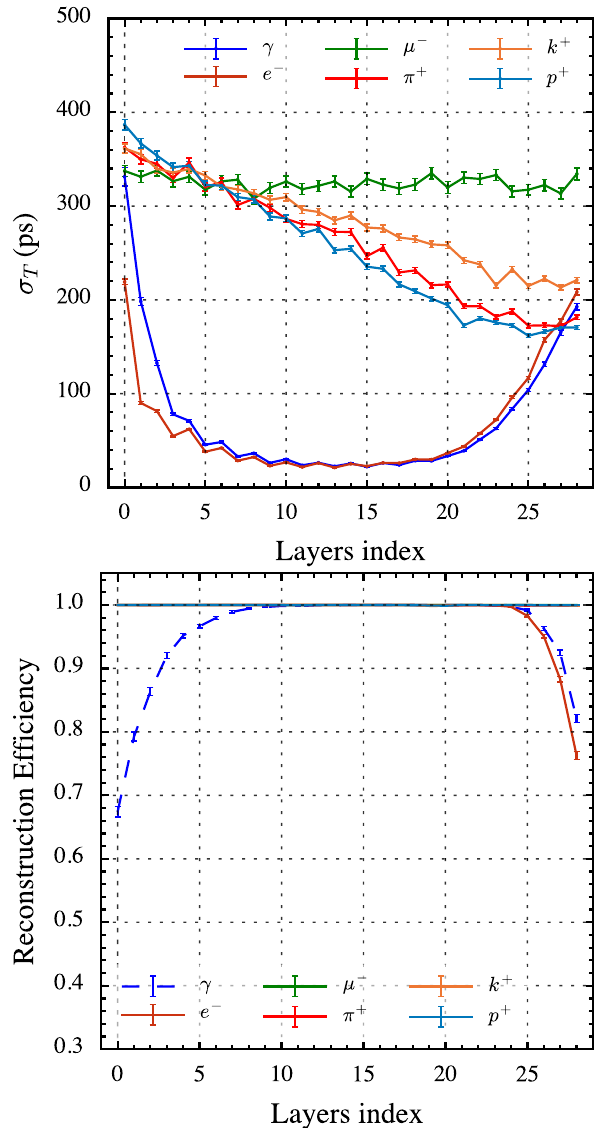
Fig. 13 The time resolution (top) and corresponding efficiency (bot- tom) from a single layer for 25 − 30GeV particles as a function of the layer index